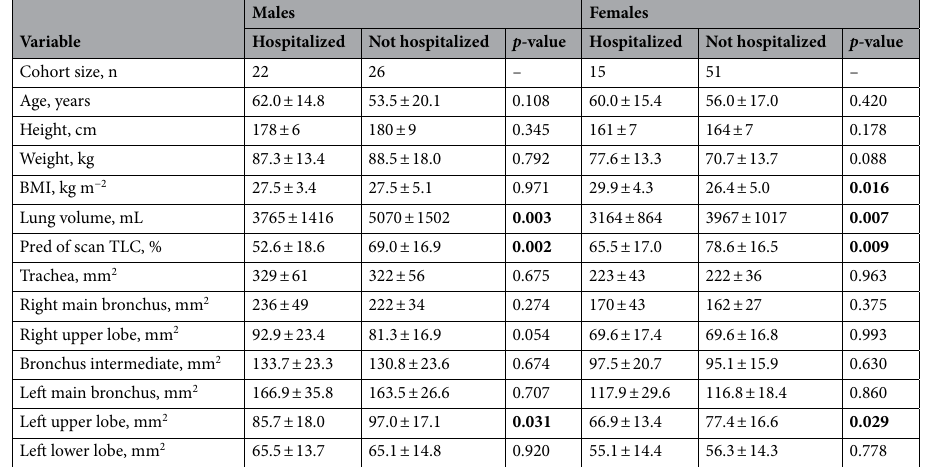
Table 3. Airway size of males and females previously diagnosed with COVID-19 comparing subsets of patients that were hospitalized and patients that were not hospitalized for COVID-19. Data are reported as mean ± standard deviation (SD). Data are compared using one-way analysis of variance. p -values are reported for between group comparisons (hospitalized vs. not hospitalized) for males and females separately. BMI, body mass index; Pred of scan TLC, predictive relation lung volume based on the computed tomography scan, absolute measured volume, and predicted total lung capacity. Significant values are in